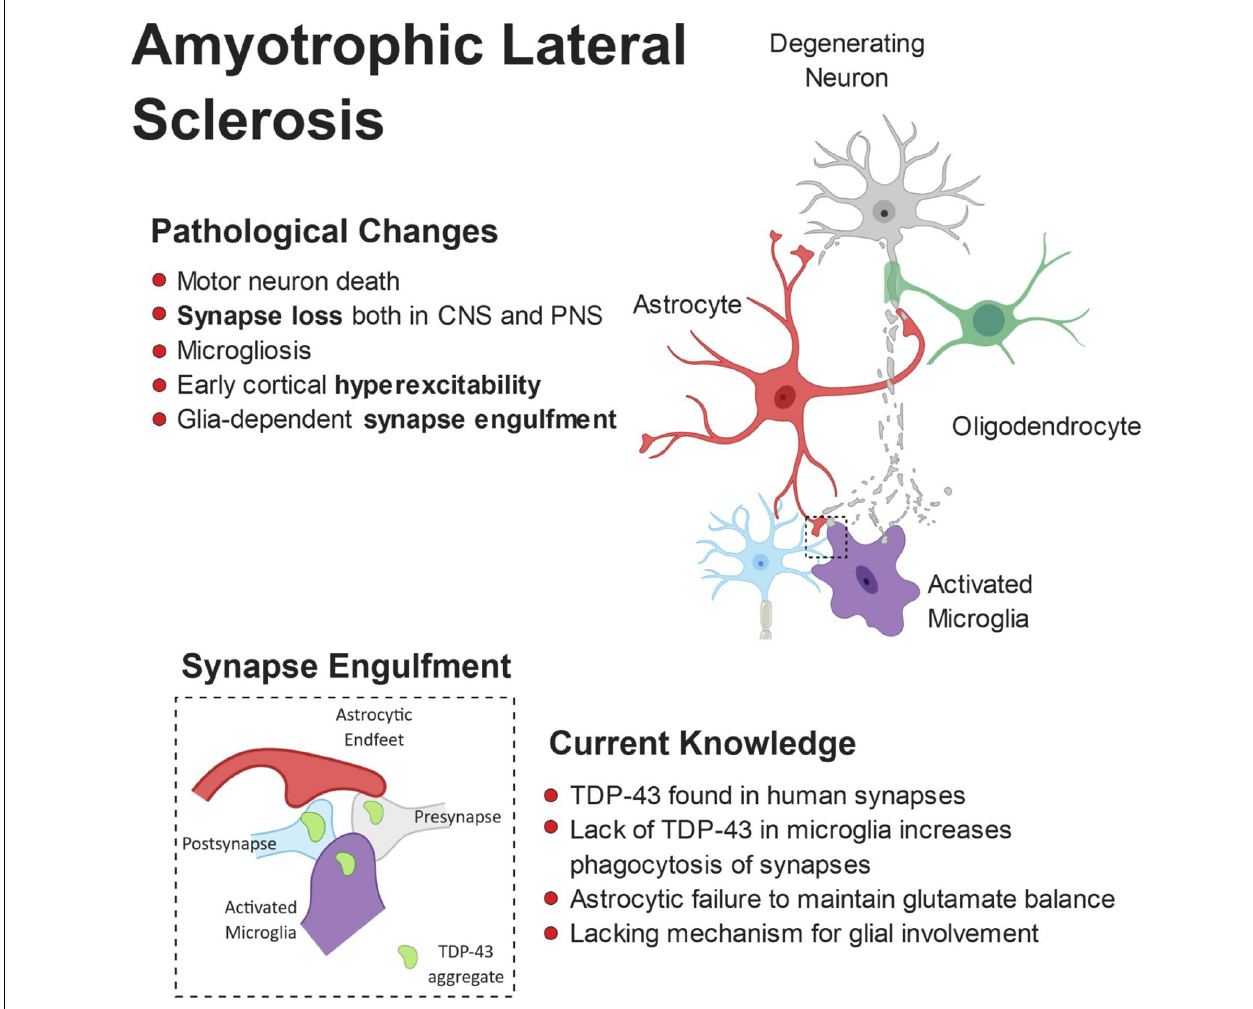
FIGURE 4 | Pathophysiology of amyotrophic lateral sclerosis (ALS). ALS is characterized by the breakdown of motor neurons in the motor cortex and spinal cord. Gliosis and cortical hyperexcitability are early features of the ALS brain and aggregates of TDP-43 are found in almost all patients. TDP-43 has been found at human synapses in ALS and the removal of TDP-43 from microglia leads to hyperphagocytic cells that engulf synapses. Microglia have been shown to engulf neuronally-derived TDP43. Interestingly, synapse loss is an early feature of ALS and observed in both the central and peripheral nervous